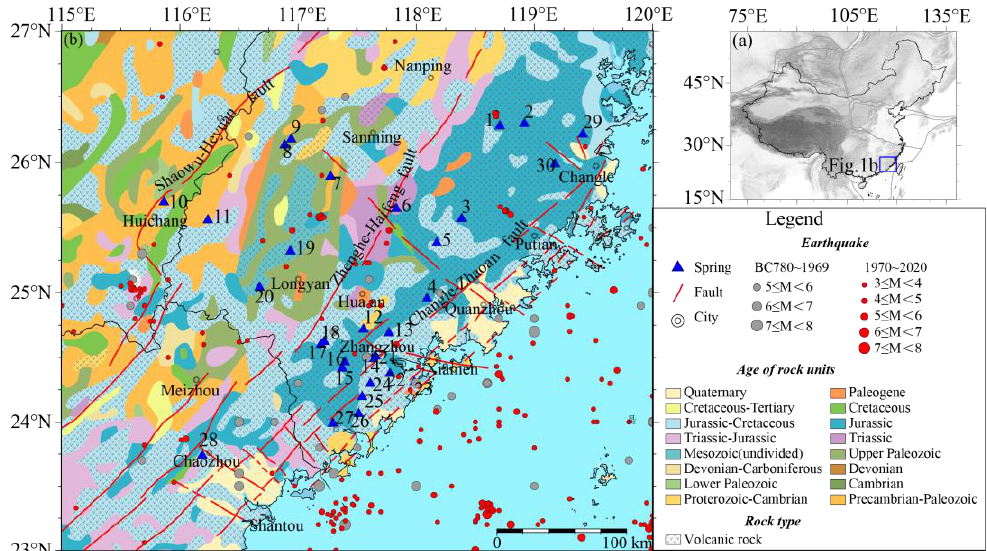
Figure 1. ( a ) Localization of the study area. ( b ) Geological map showing the location of the thermal springs, historical earthquakes and major faults of Fujian.